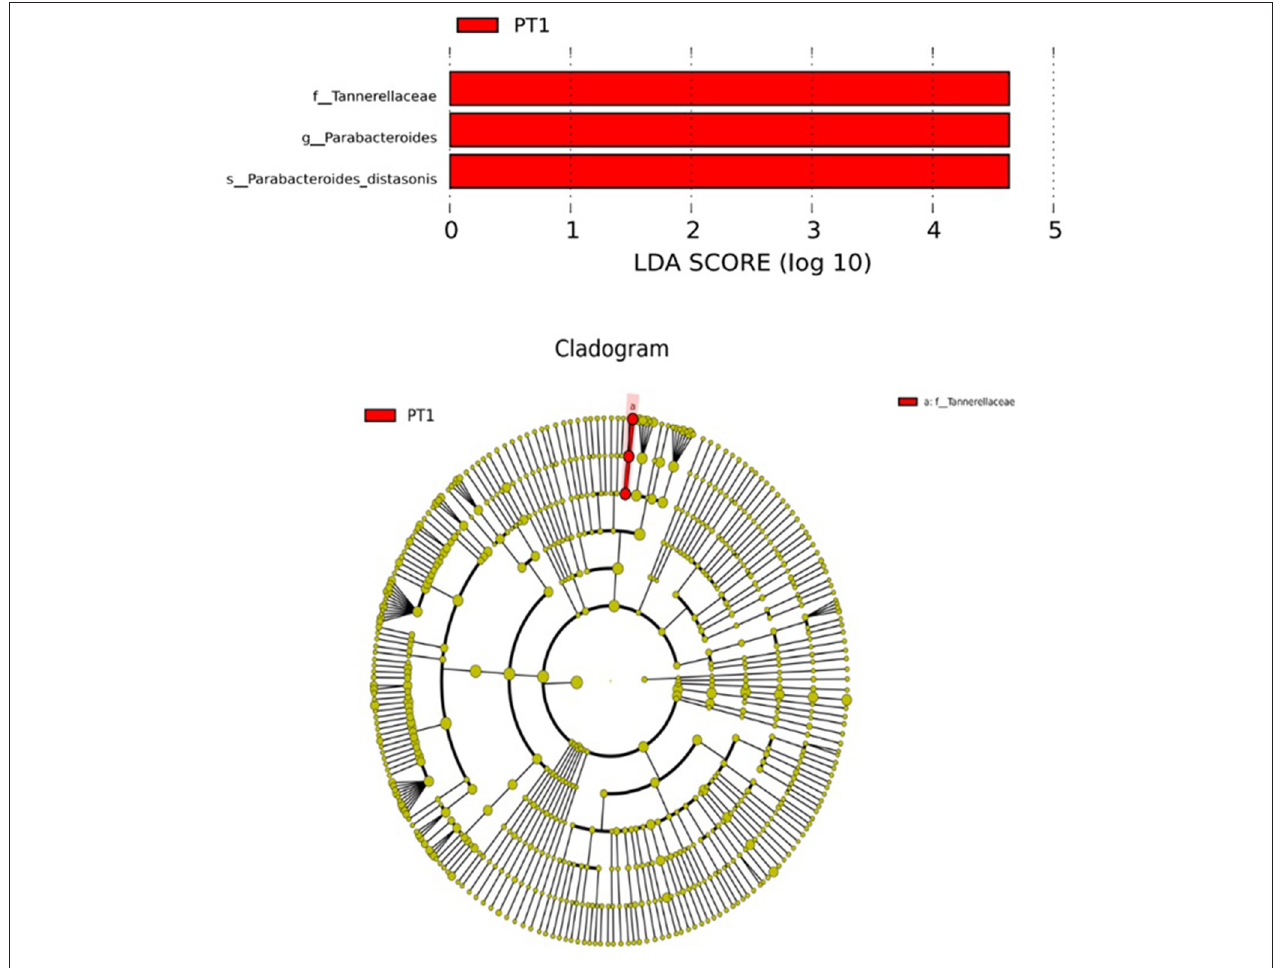
FIGURE 1 | Differential intestinal flora between groups